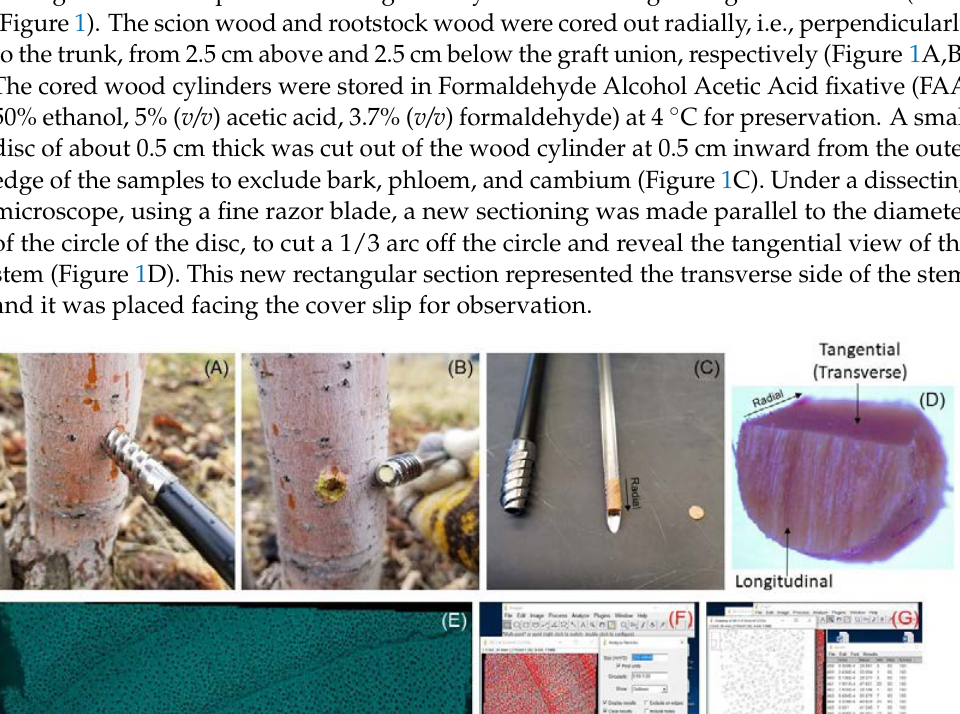
vessel elements.